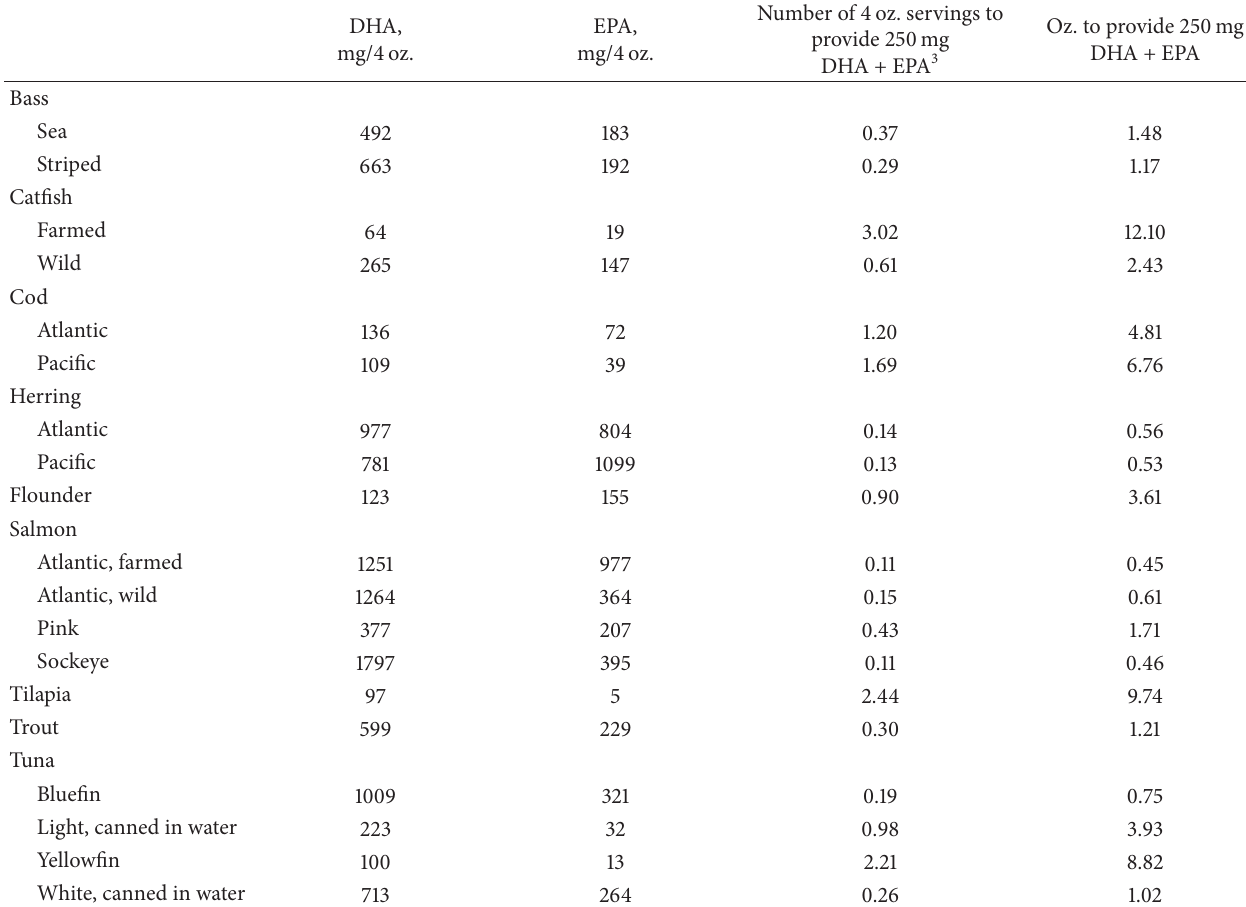
Table 1: DHA and EPA content of major dietary sources of omega-3 LCPUFA 1,2